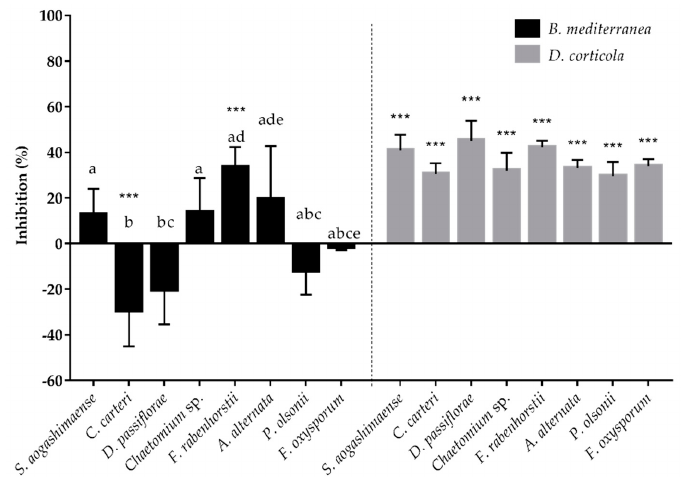
Figure 4. Inhibition of B. mediterranea and D. corticola growth caused by the tested endophytic fungi in dual-culture assay. Negative values indicate that the area of the plate covered by the interacting pathogen was higher than that of the control. Different letters represent statistical significance ( p ≤ 0.005) between endophytes in each antagonistic assay and *** ( p ≤ 0.001) represents statistical significance between the control and co-culture of a pathogen.